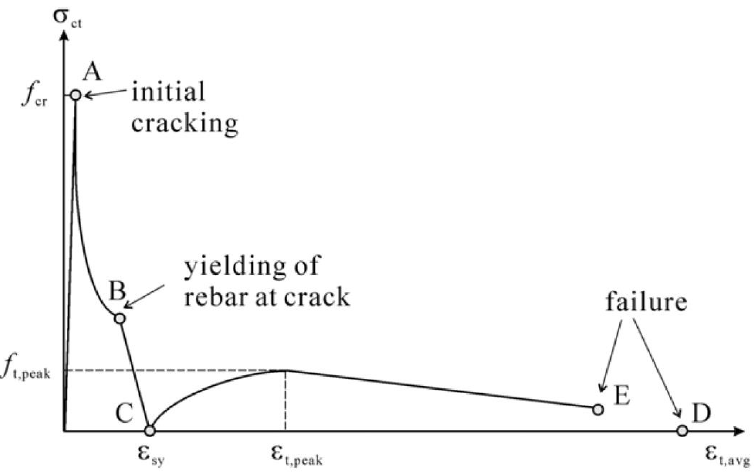
Figure 9. A tension stiffening